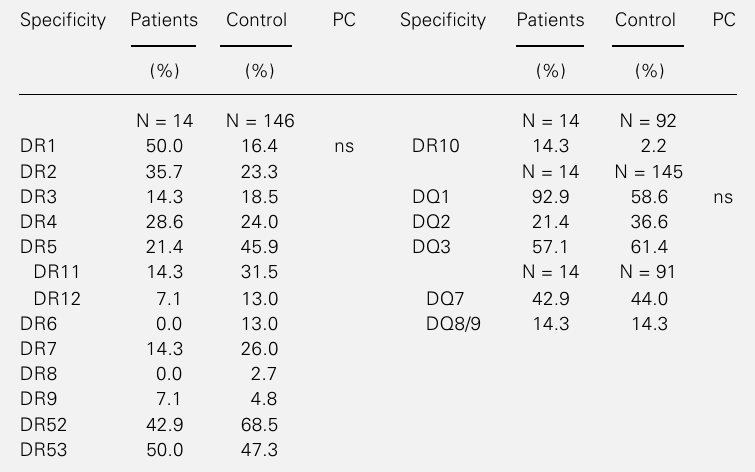
Table 5 - HLA-DR and DQ antigen frequencies in patients with the I form of leprosy and in the control group. ns = Nonsignificant (indicated only if P<0.05 before correction); P = probability; PC = corrected probability (Chi-square test). Specificity